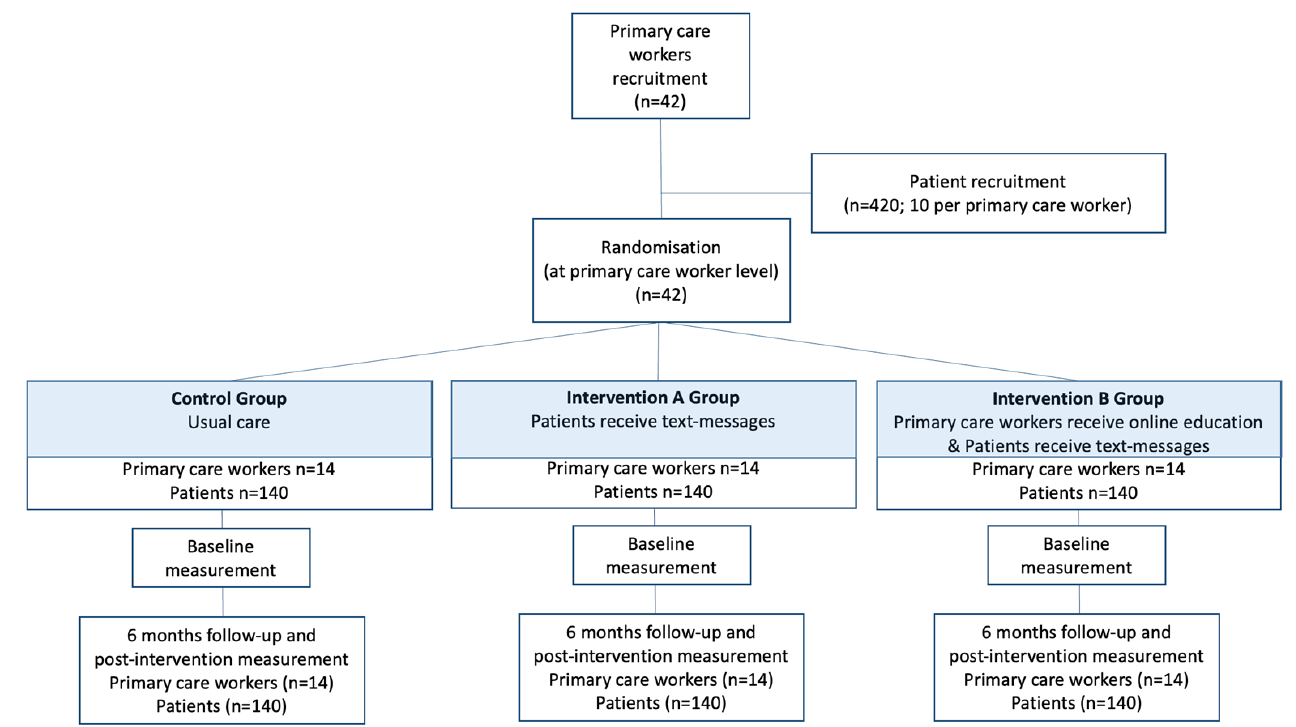
Figure 3. Consort flowchart of the PreDiabeText phase II clinical trial.